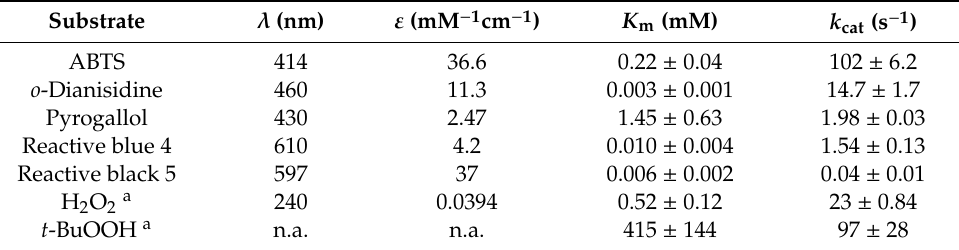
Table 1. Kinetic parameters measured for Pf DyP B2.